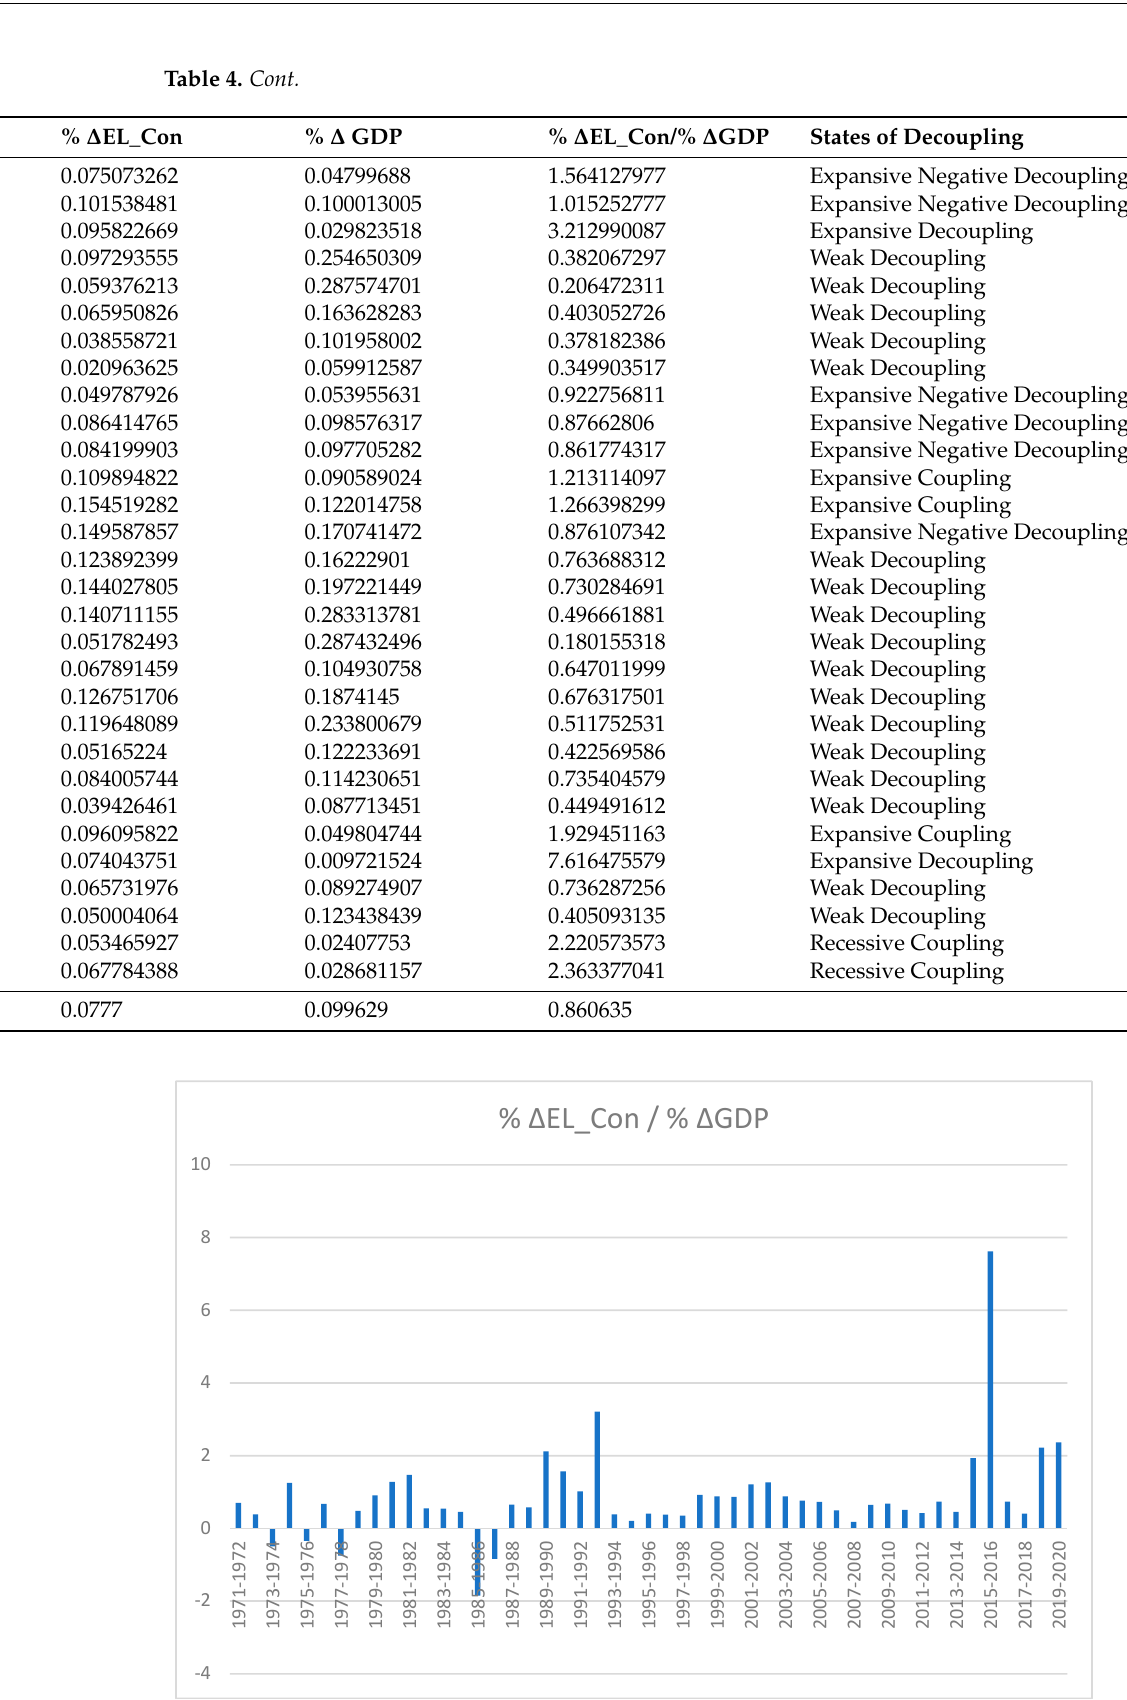
Here we have explored the linkage between CO 2 emissions and consumption of elec- tricity with decoupling states comparison. Table 5 and Figure 6 display the decoupling states in five types: strong decoupling, weak decoupling, expansive coupling, expansive